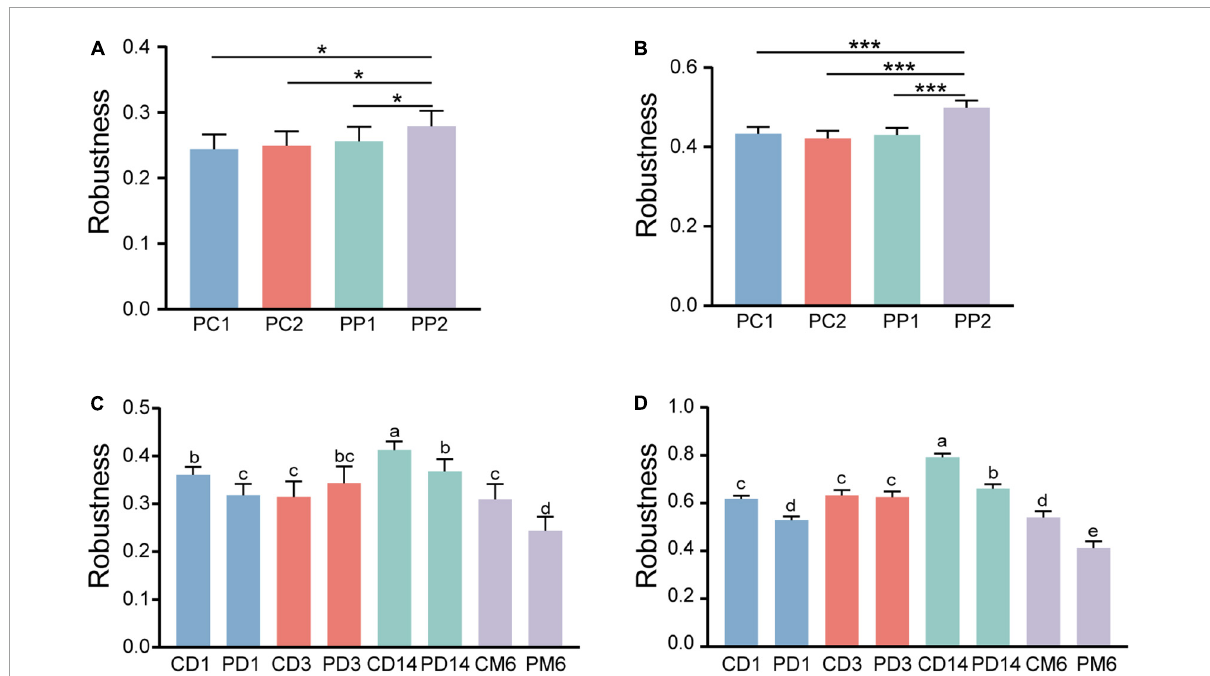
FIGURE7 Microbial network stability of pregnant women and infants. Robustness of pregnant women is measured as the proportion of the remaining taxa after (A) randomly removing 50% of nodes and (B) 50% of potential keystones taxa. Statistical significance was determined by the one-way ANOVA. * P < 0.05; *** P < 0.001. Panels (C,D) showed the robustness of infants. The calculation method is the same as panels (A,B) , respectively. Different lowercase letters above the bars indicate differences with P < 0.05, whereas the same letter indicates no significant